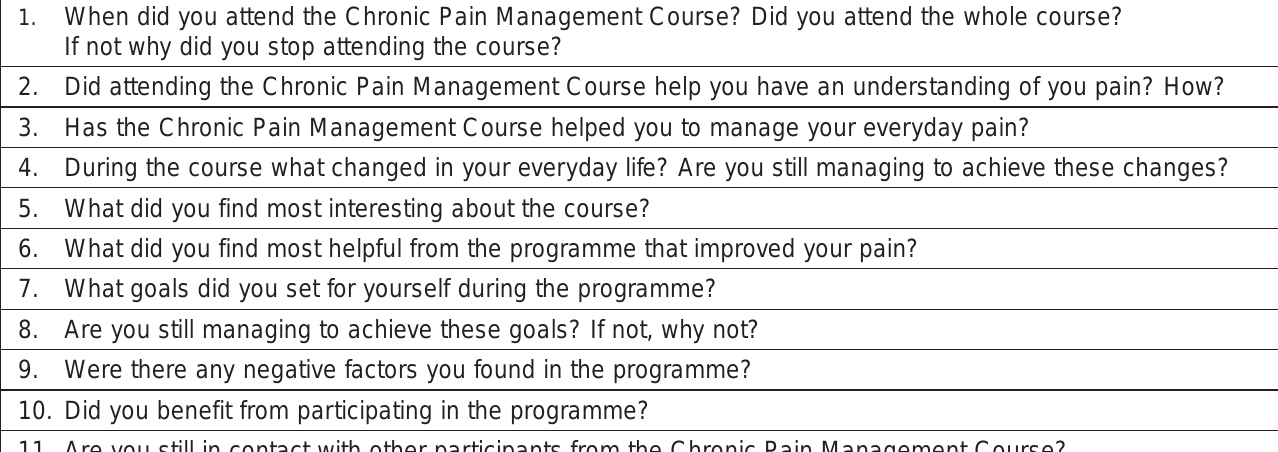
Table 1. Structured Questions used in the Participant